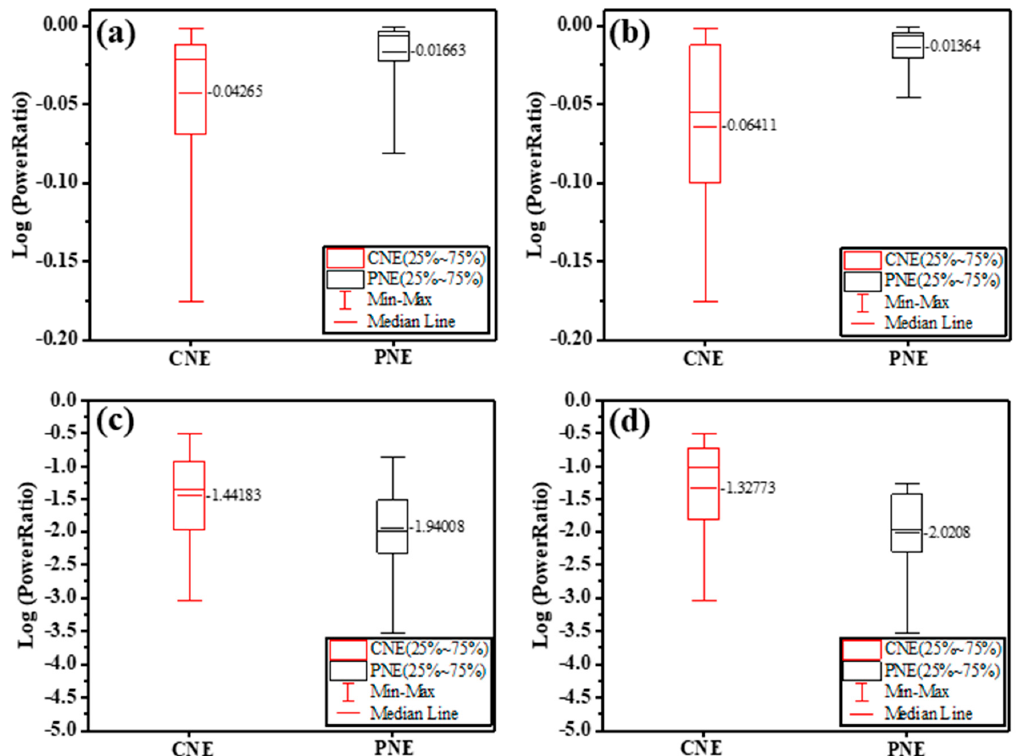
Figure 5. LFP signals measured from the cortices of Sprague-Dawley rats in the range 1 Hz to 49 Hz at ( a ) 1 mm to 5 mm (1 mm increment) and ( b ) specifically at 1 mm depth; Noise recorded in the range 59 Hz to 61 Hz ( c ) at 1 mm to 5 mm (1 mm increment), and ( d ) specifically at 1 mm depth.